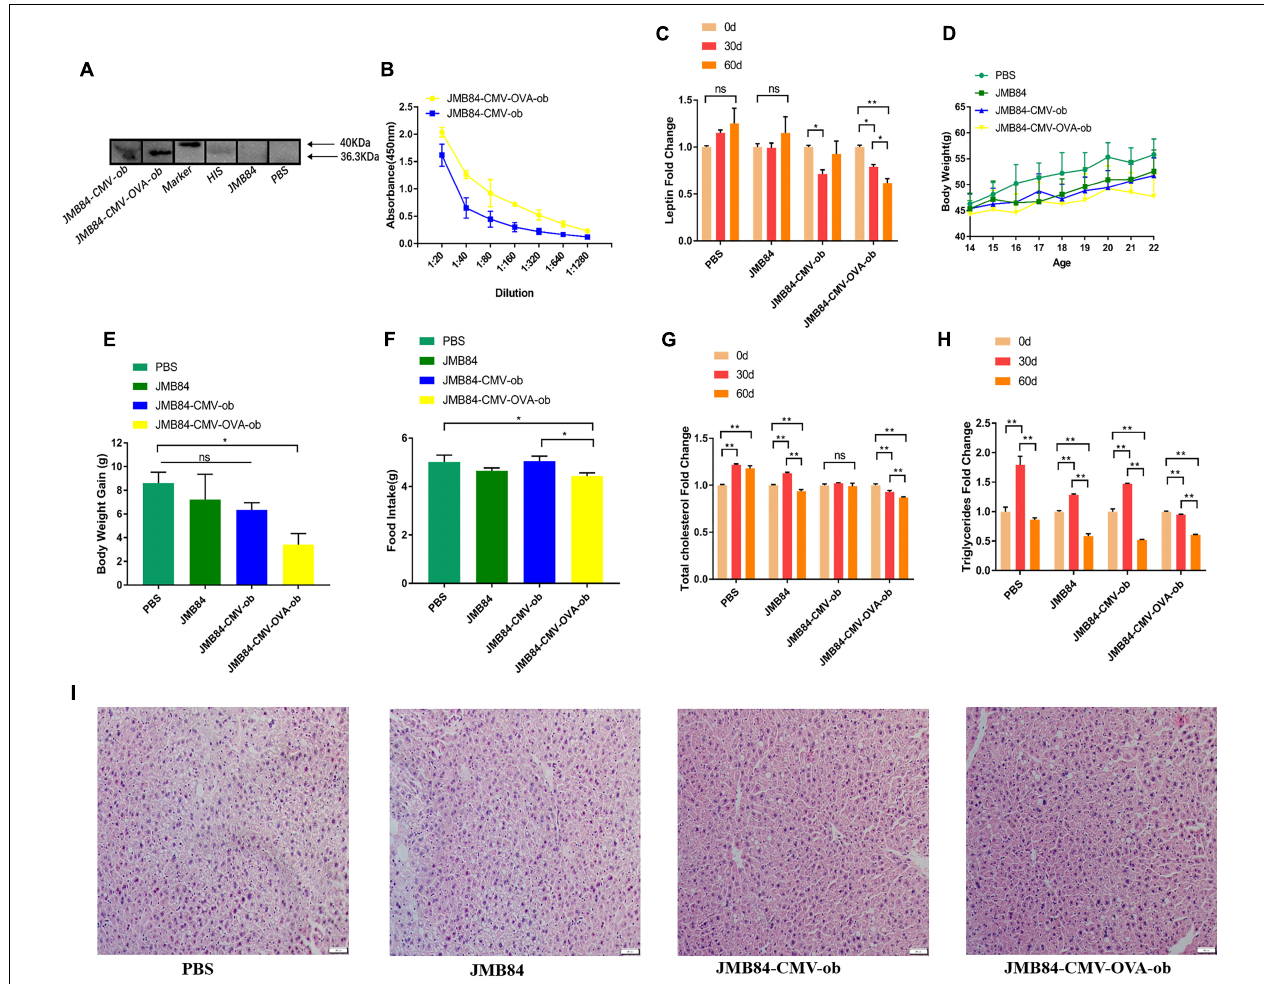
FIGURE 3 | Oral administration of ob recombinant yeast relieves leptin resistance in DIOing mice. (A) WB assay result for the qualitative detection of anti-leptin antibodies in different antiserums (Day60) from different treatments. (B) ELISA result for anti-leptin antibody titering in the antiserums (Day60) from the oral immunized mice by ob recombinant yeast. (C) The changes of circulating leptin detected by ELISA in the antiserums (Day0, Day30, and Day60) from different treatments. (D) The weekly average body weight of the mice from different treatments. The age was indicated as weeks, and the mice were orally immunized at 14-week-old. (E) The comparison of the average body weight gain of the mice from different treatments at the end of oral immunization (Day60). (F) The comparison of the average daily feed intake of the mice from different treatments during the oral immunization. (G,H) The changes in total cholesterol and triglyceride were detected